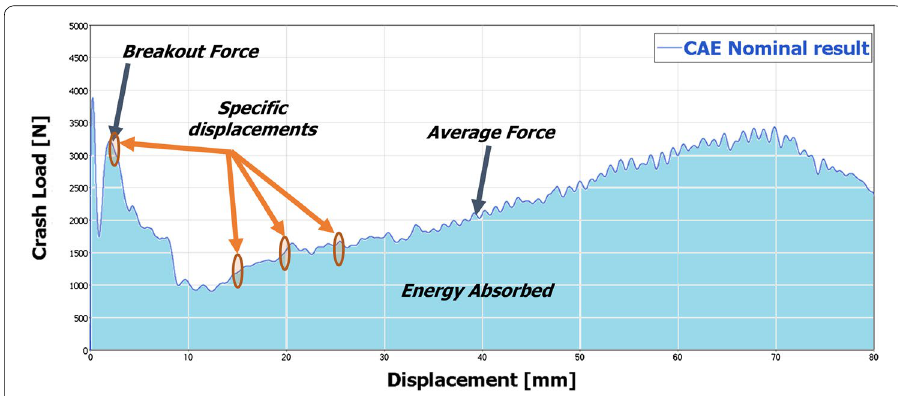
Fig. 11 Graph with the difference responses, and points of response